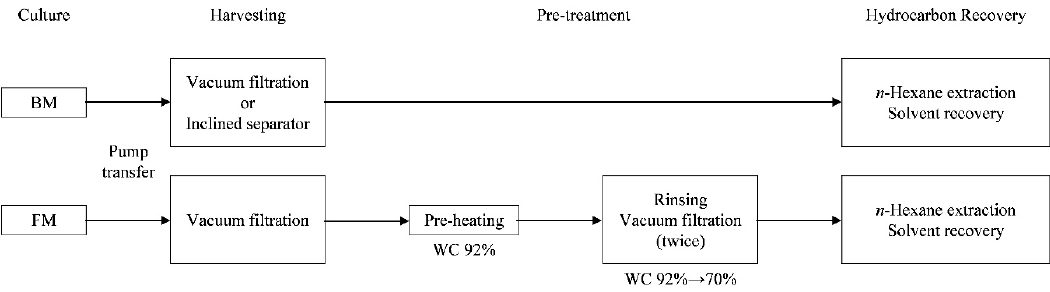
Figure 2. Hydrocarbon production from algal cultures in brackish medium (BM) or freshwater medium (FM) with pre-heating before the hydrocarbon extraction. WC: Water content. Table 1. Parameter values used to calculate the energy profit ratio.